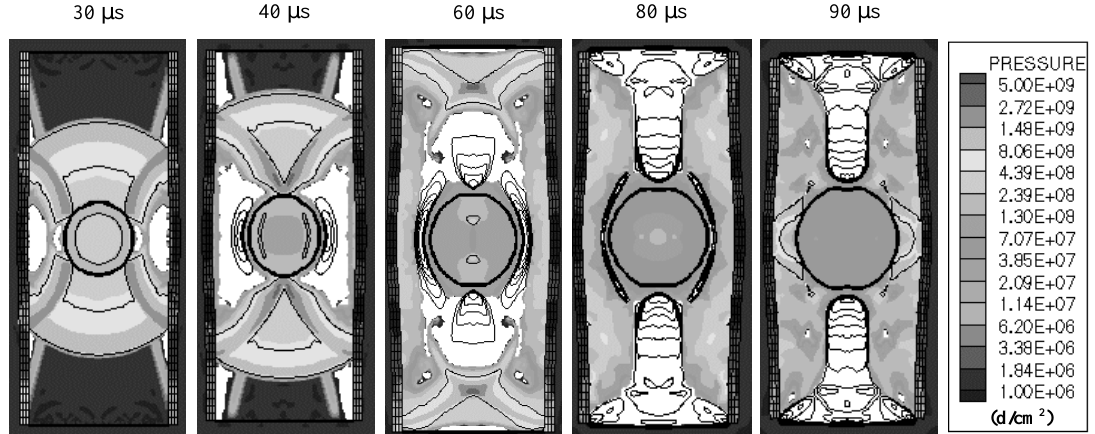
Fig. 6. Pressure contours in the evolving flow field of the single wall cylinder flow case.